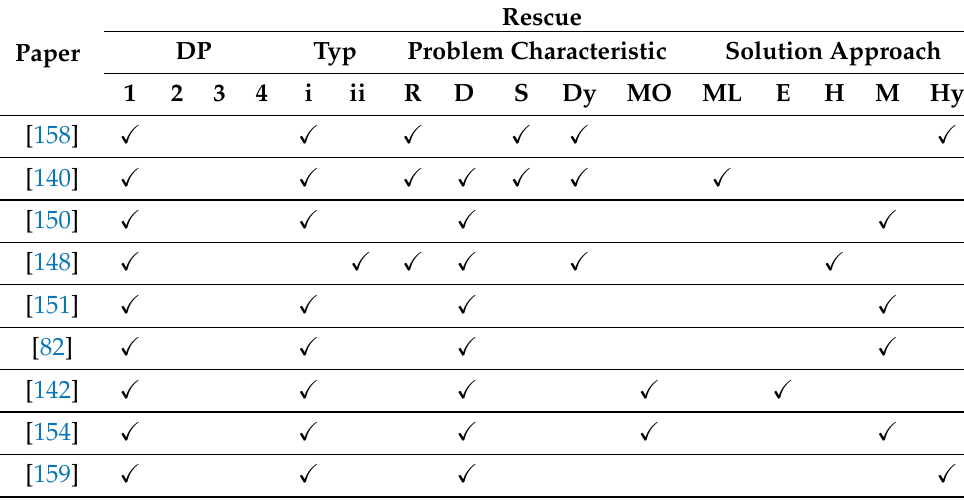
Table A6. VRPs for Rescue in Humanitarian